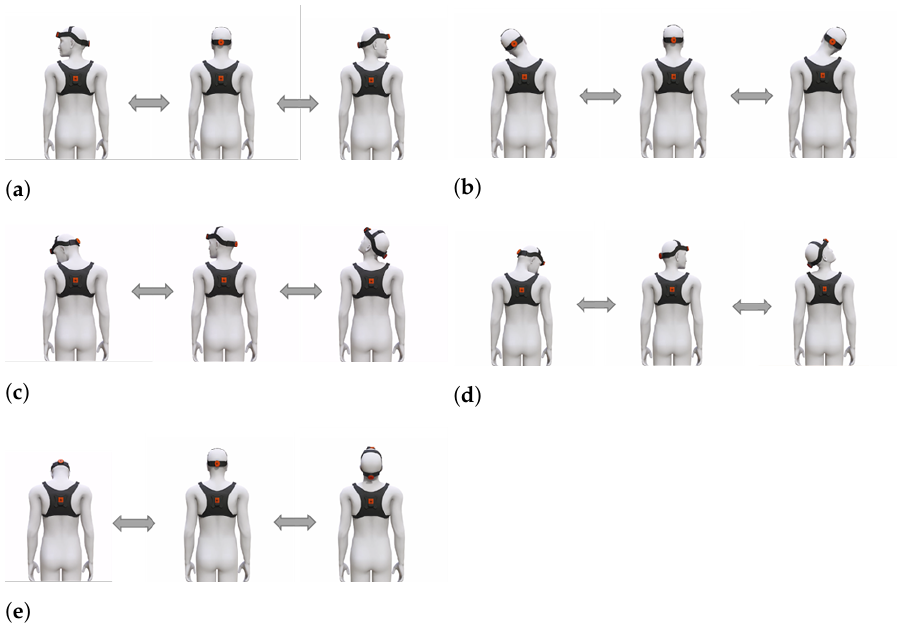
Figure A1. Instructions provided for participants to perform motion evaluations in each plane.